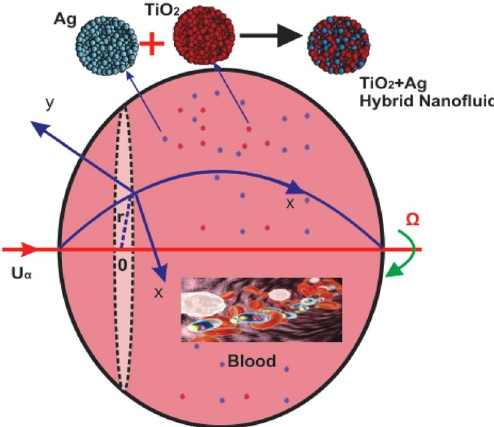
Figure 1. Configuration of model problem.